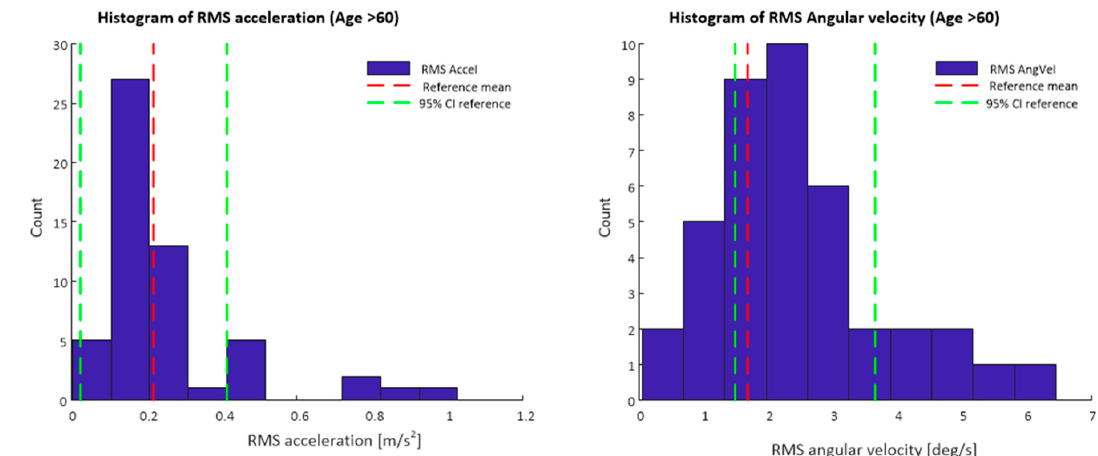
Figure 3. Histograms of RMS acceleration and RMS angular velocity values from smartphone inertial sensor data. Mean values and 95% confidence intervals for the reference data set are also marked.